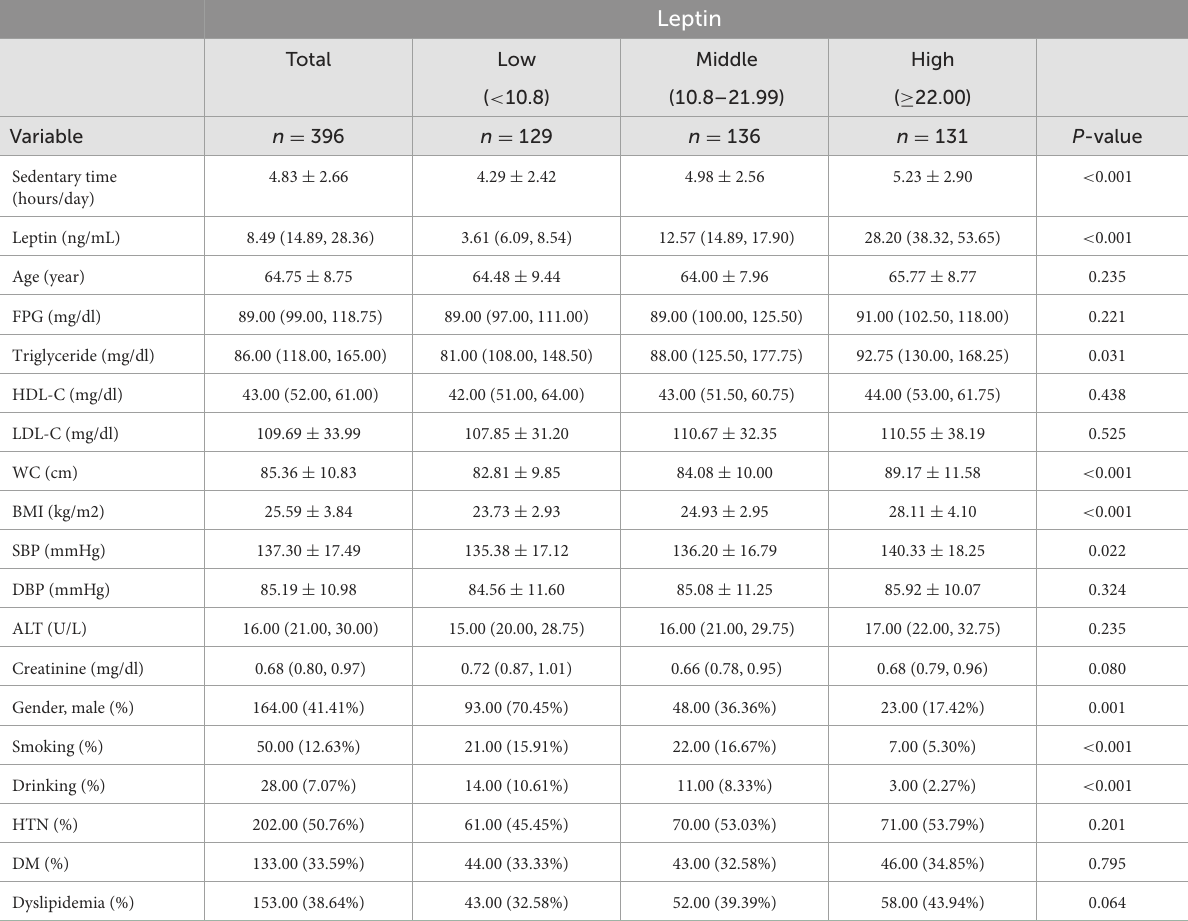
TABLE 1 Clinical characteristics and biochemical variables of study subjects according to tertiles of leptin level.